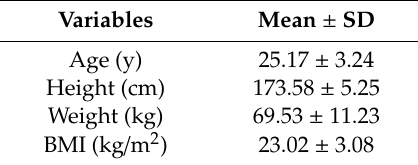
Table 1. Characteristics of